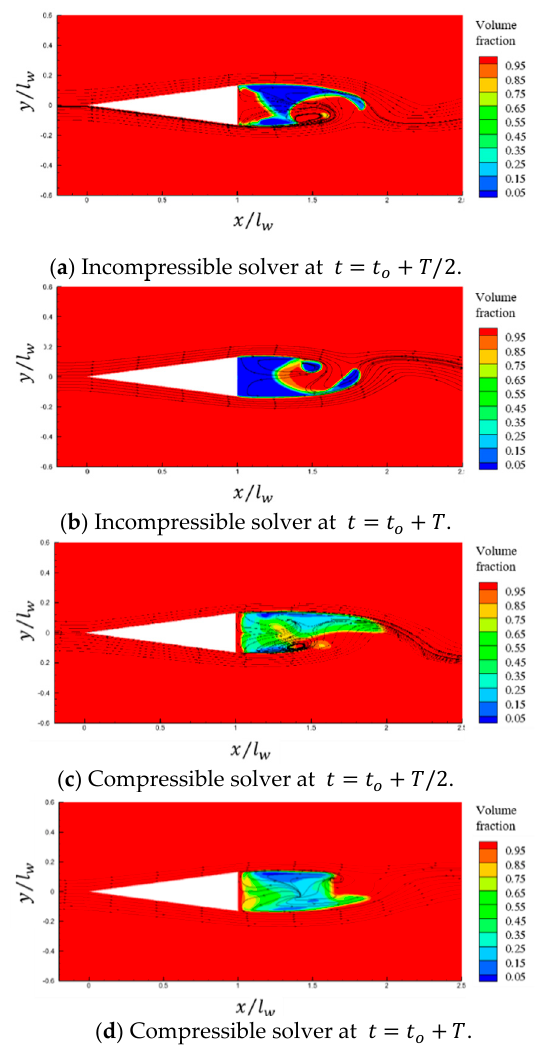
Figure 14. Cavity shedding dynamics and streamlines around wedge at σ = 0.83.